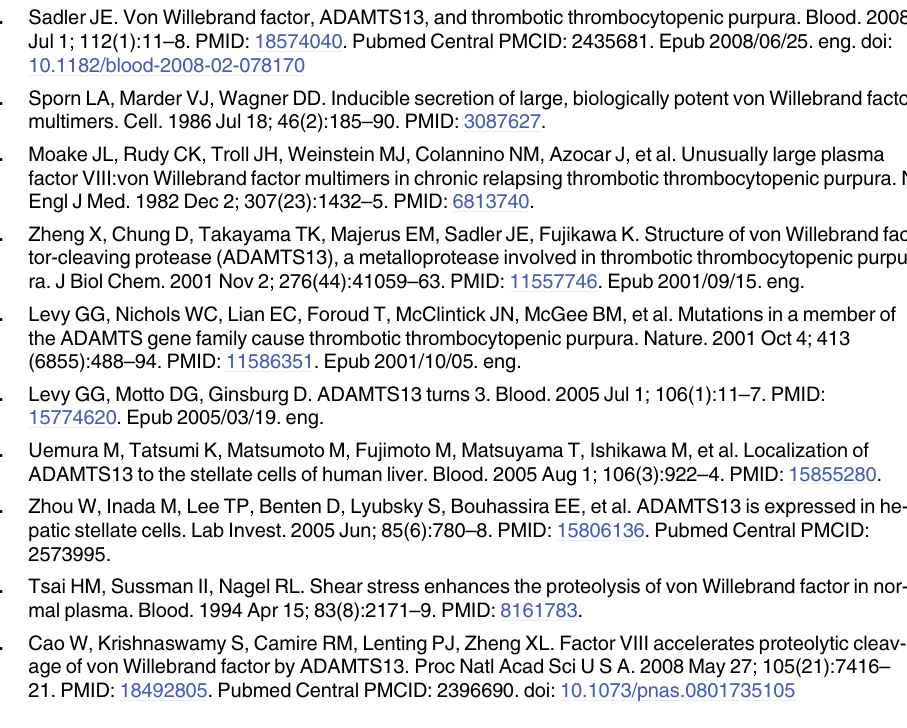
S1 Fig. Comparison of VWF73 sequence from screen derived phage to wild type. Individual phage colonies that were resistant to ADAMTS13 were Sanger sequenced. DNA sequence was translated into peptides using the EditSeq software package. Phage protein sequences were im- ported into the MegAlign software package and aligned with wtVWF73 protein sequence. Phage are ordered by the location of the first missense mutation. Only amino acids differing from the wtVWF73 are noted with